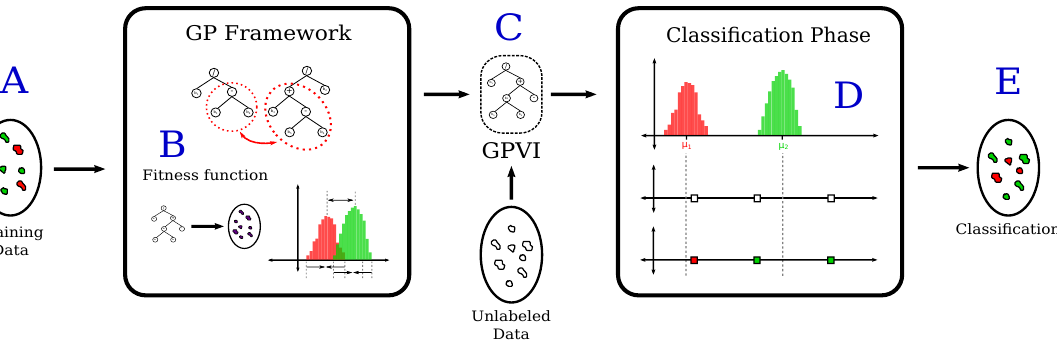
Figure 1. Genetic-Programming-based vegetation indices (GPVI) learning process and posterior classification framework for pixelwise discrimination. The labeled training set is represented by the set defined by part “A”. This ground truth is then used in the GP-based index discovery process in part “B”—see Sections 3.1 and 3.2. Classification is performed based on the best GP individual (GPVI) found—part “C”. This individual is used to define a score for unlabeled samples and to define the index distributions per class. Finally, unlabeled samples are assigned to the class whose distribution is the closest—part